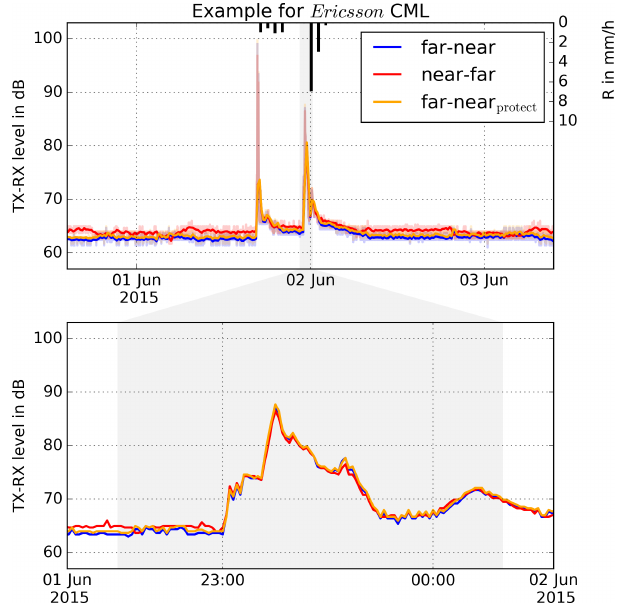
Figure 3. Example data record of an Ericsson MINI-LINK TN CML used in the backhaul of a cell phone network. The CML has a length of 7.9km and uses frequencies of 22.078 and 23.086GHz for the two directions. The direction from the far end to the near end uses a second receiver as hot standby 1 + 1 system. Top: the solid lines show the 15min averages of the TX-RX level (transmitted mi- nus received signal level). The lines with the lighter color show the raw data with 1min resolution. In addition, hourly rain rates from a DWD rain gauge in the vicinity of the CML are shown (black bars) to indicate the strong sensitivity of the CML path attenuation to rain rate. Bottom: zoomed-in version of the plot above showing only the raw 1min